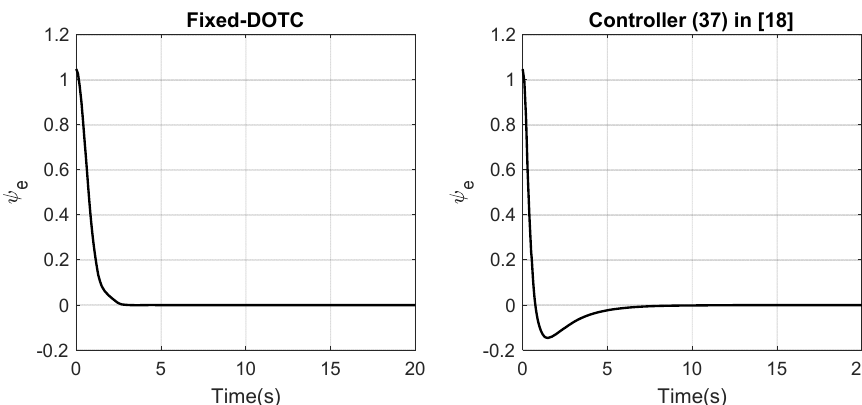
Figure 11. The orientation tracking error in part 2.